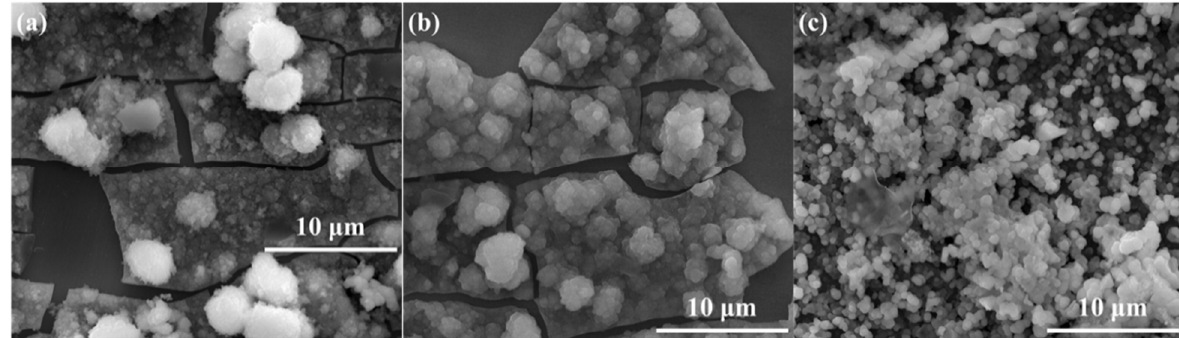
Figure 7. The SEM images of 304 stainless ‐ steel samples after being treated by polarization measurements in different solutions and a 4 week immersion test in SG + Na 2 SeO 3 solution: ( a ) SG + CaCl 2 solution; ( b ) SG + Na 2 CO 3 solution; ( c ) SG + Na 2 SiO 3 solution.